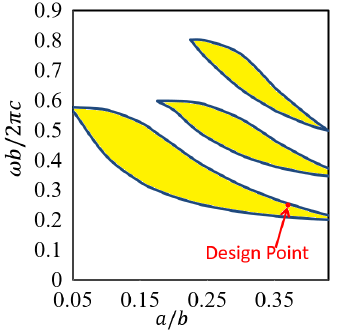
FIG. 2. TM mode band gap map of a 2D lattice of sapphire rods of radius a and spacing b